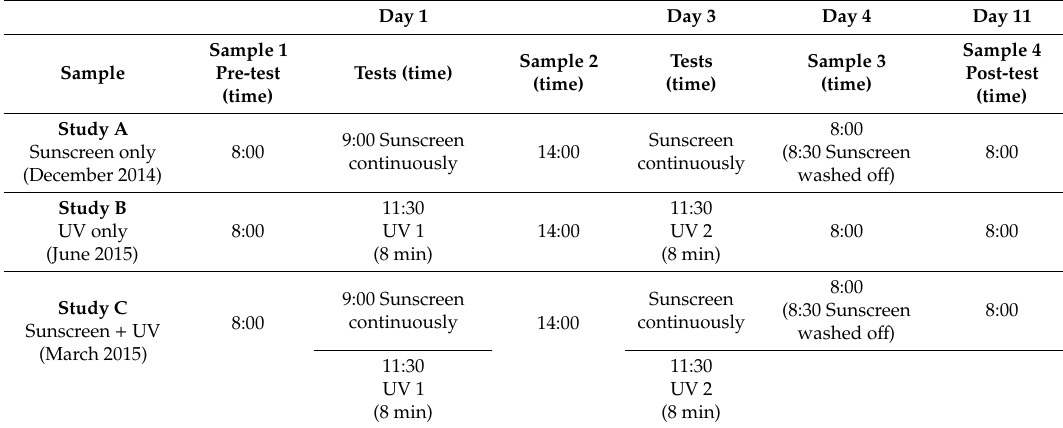
Table 1. Schedule of the three study variants, exposure times, and sampling of the blood plasma, spot urine, and exhaled breath condensate